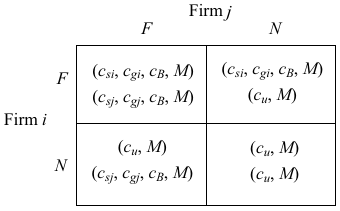
Fig. 8. Asymmetric